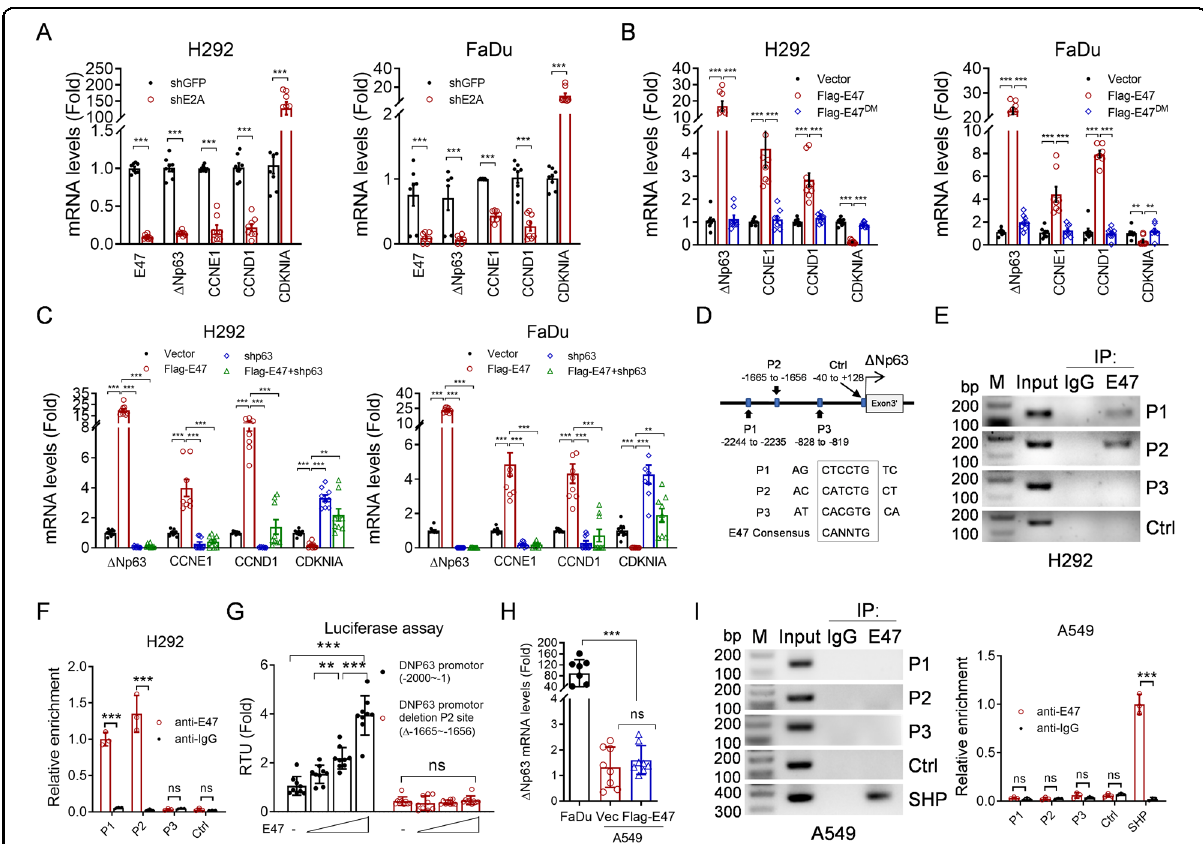
Fig. 3 Wild-type E47, but not E47 DM mutant, directly transactivate Δ Np63 α . A H292 or FaDu cells stably expressing shRNAs against E2A or control were subjected to Q-PCR analyses. Three independent experiments were performed. Data were presented as mean ± SD. *** p < 0.001. B H292 or FaDu cells stably expressing wild-type E47, E47 DM mutant, or a vector control were subjected to Q-PCR analyses. Three independent experiments were performed. Data were presented as mean ± SD. ** p < 0.01, *** p < 0.001. C H292 or FaDu cells stably expressing either Flag-E47 or shp63, or both were subjected to Q-PCR analyses. Three independent experiments were performed. Data were presented as mean ± SD. ** p < 0.01, *** p < 0.001. D Three putative E47-binding elements (P1: − 2244 to − 2235; P2: − 1665 to − 1656; P3: − 828 to − 819) and a negative control (NC: − 40 to + 128) on Δ NTp63 gene promoter were predicted by JASPAR software and E47-binding consensus sequence are depicted. E – F ChIP assays were performed in H292 cells using a speci fi c E2A antibody (anti-E47) or a control rabbit normal IgG (anti-IgG) and primers speci fi c for P1, P2, and P3. A randomly segment ( − 40 to + 128) on Δ Np63 gene promoter was used as negative control (Ctrl). Q-PCR analyses of ChIP samples were performed. *** p < 0.001. G HEK293T cells were co-transfected with 0 ng, 100 ng, 200 ng, or 400 ng E47 and 100 ng Δ Np63-Gluc-SEAP reporter or its deletion mutation ( Δ − 1665~ − 1656) expressing plasmid for 36 h, and then the cell culture media were collected and Δ Np63-Gluc and SEAP activities were measured. The Δ Np63-Gluc activity was normalized to SEAP activity. Three independent experiments were performed. Data were presented as mean ± SD. ** p < 0.01, *** p < 0.001. H FaDu or A549 cells stably expressing wild-type E47 or a vector control were subjected to Q-PCR analyses. Three independent experiments were performed. Data were presented as mean ± SD. *** p < 0.001. I ChIP assays were performed in A549 cells using a speci fi c E2A antibody (anti-E47) or a control rabbit normal IgG (anti-IgG) and primers speci fi c for P1, P2, and P3. A randomly segment ( − 40 to + 128) on Δ Np63 gene promoter was used as negative control (Ctrl). SHP ( − 474 to − 120) was used as a positive control. Q-PCR analyses of ChIP samples were performed. *** p <